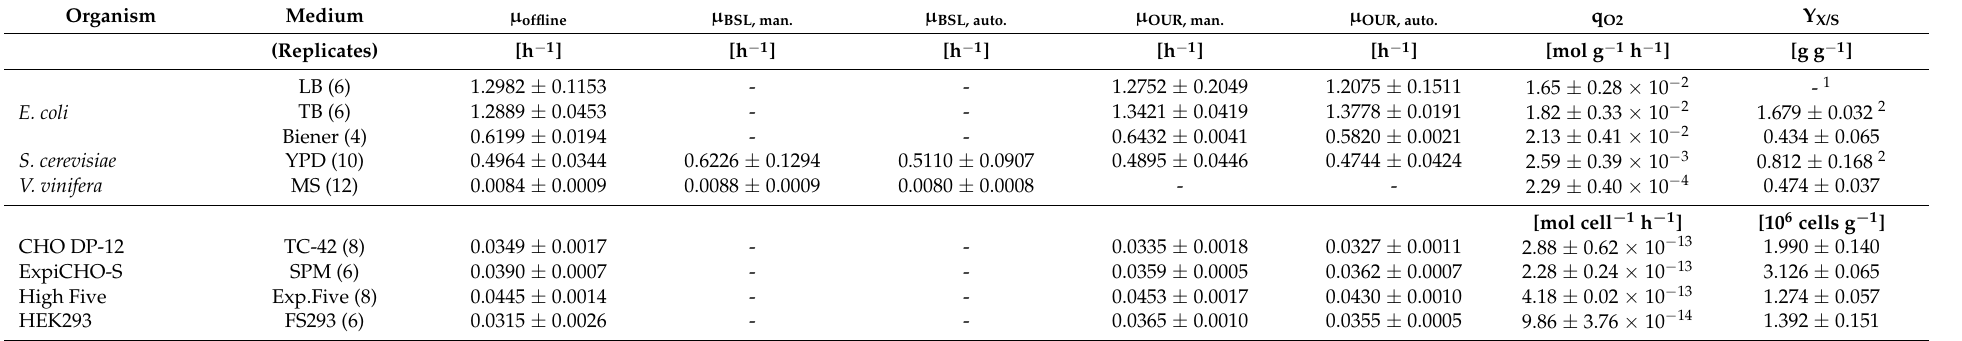
Table 3. Overview of the KPIs for all investigated organisms under standard conditions described in Section 2. For every investigated organism–medium combination, the number of replicates is indicated in brackets (replicates). µ offline was calculated based on measurements of cell dry weight for E. coli , S. cerevisiae and V. vinifera and viable cell density for CHO, HEK and High Five cells. The calculation of µ BSL and µ OUR was distinguished between manual ( man ) and automatic ( auto ) evaluation. The use of the BSL signal appeared to be useful only for S. cerevisiae and V. vinifera , whereas the use of the OUR only for V. vinifera did not seem to be purposeful. The calculated cell-specific oxygen uptake rates and biomass yields are based on the biomass measurements typically used for the organisms, i.e., cell dry weight for E. coli , S. cerevisiae and V. vinifera , and viable cell density for CHO, HEK and High Five.